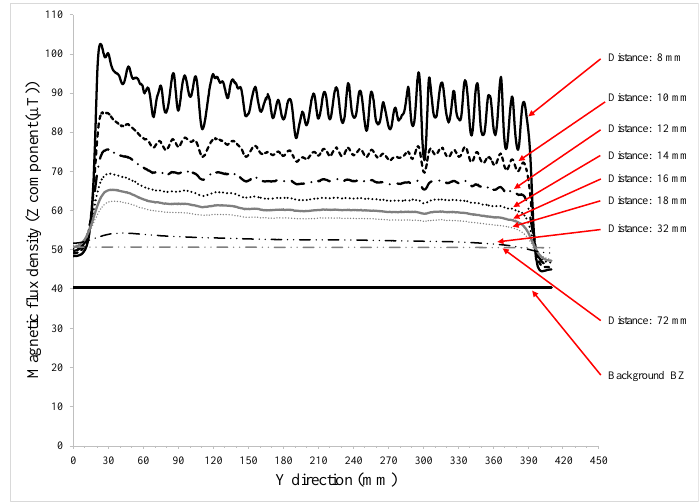
Figure 16. Values of magnetic flux densities of rebar mesh #8 and box mesh #5 at different vertical distances from the center of the rebar.